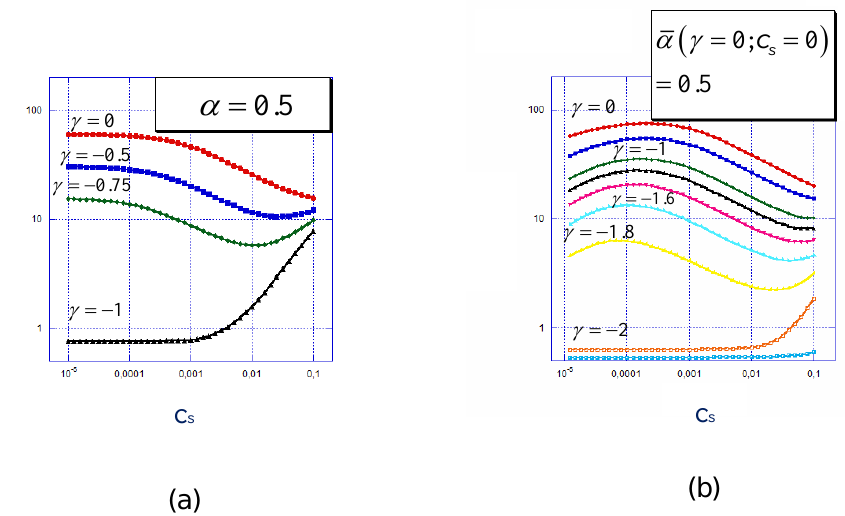
Figure 4. The average thickness, (cid:104) H (cid:105) , (the first moment of the polymer density distribution) of strong ( a ) and weak ( b ) polyelectrolyte brushes as a function of salt concentration at different values of the surface charge density (as indicated at the curves). Other parameters: N = 300, a 2 / s = 0.001. At positive or weakly negative γ , the brush structure in salt-free solution and its response to increasing salt concentration is qualitatively the same as for the brush tethered to a non-charged surface: The brush remains virtually intact as long as the concentration of added salt is smaller than the concentration of counterions entrapped inside the brush whereas at sufficiently high salt concentration the brush thickness noticeably decreases and then levels off at the value controlled by non-electrostatic (excluded volume) interactions. An opposite trend is observed at γ ≈ − 1: In the absence of salt, all the chains are adsorbed onto the oppositely charged surface and form a thin and dense adsorption layer. An increase in salt concentration leads to the screening of the Coulomb attraction between the surface and the polyelectrolyte chains. This screening becomes efficient when the salt-controlled Debye length becomes smaller than the adsorbed layer thickness leading to progressive desorption of the tethered